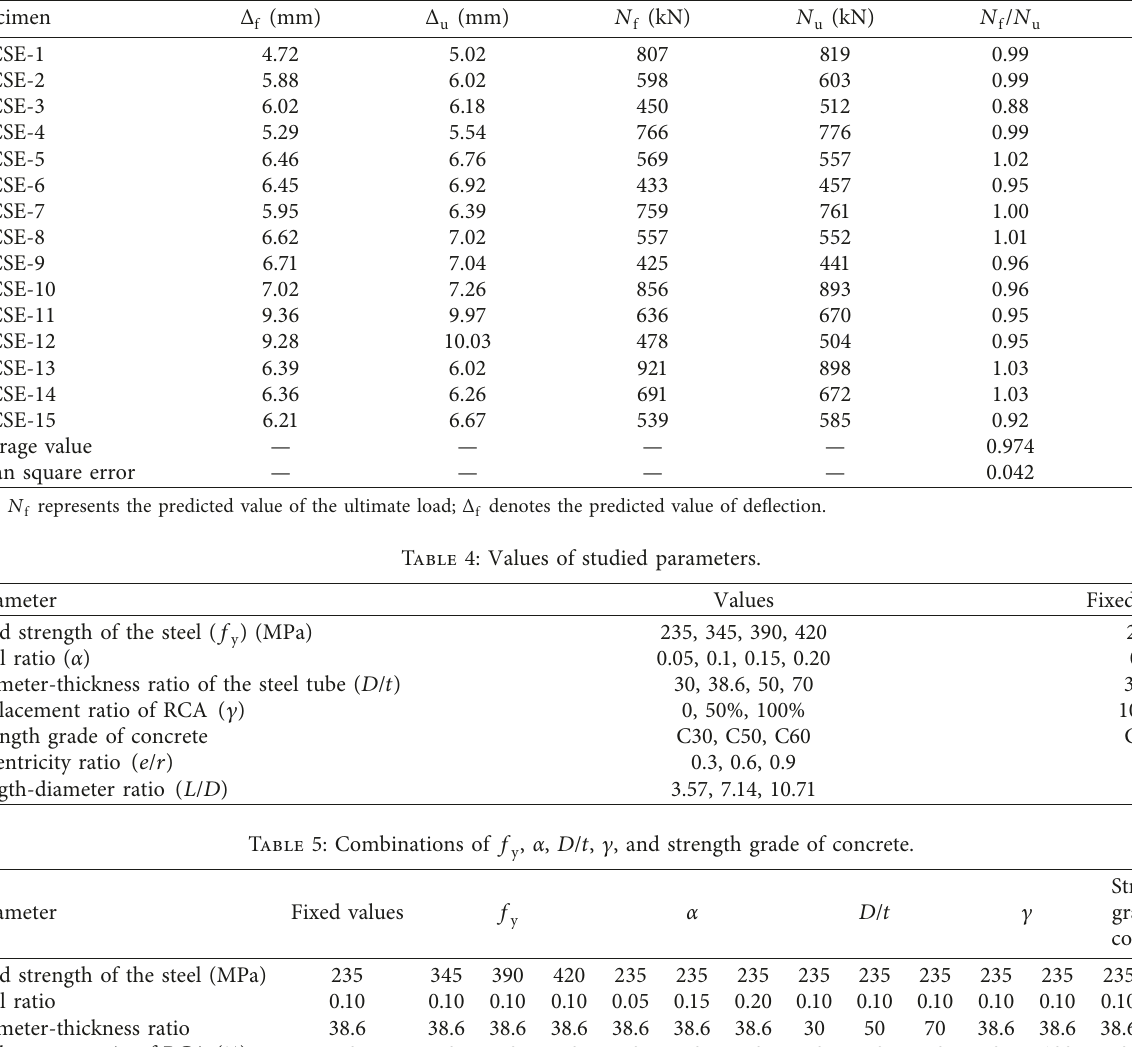
, α , D / t , c , and strength grade of concrete. y